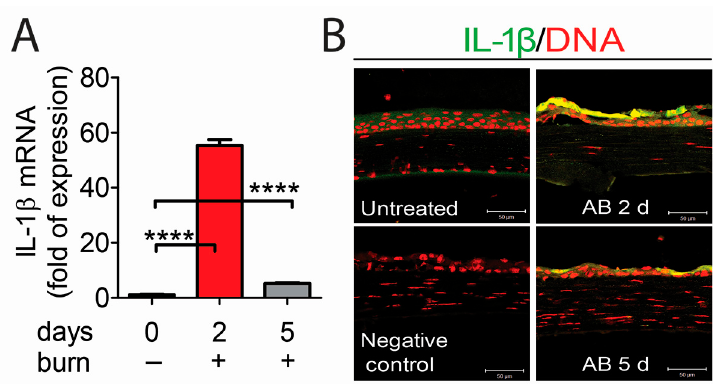
Figure 4. Upregulation of interleukin (IL)-1 β in corneal epithelium in animals subjected to alkali burns (AB) at 2 days (2 d) and 5 days (5 d) post-injury. ( A ) Gene expression analysis of IL-1 β mRNA transcripts in whole corneas of eyes subjected to alkali burn ( n = 8 animals/group). **** p < 0.0001. ( B ) Representative merged digital images of laser scanning confocal microscopy in corneal cryosections immunostained for IL-1 β (green) with propidium iodide nuclei counterstaining (DNA in red) in corneas subjected to alkali burn ( n = 6 animals/group). Scale bar: 50 µm.